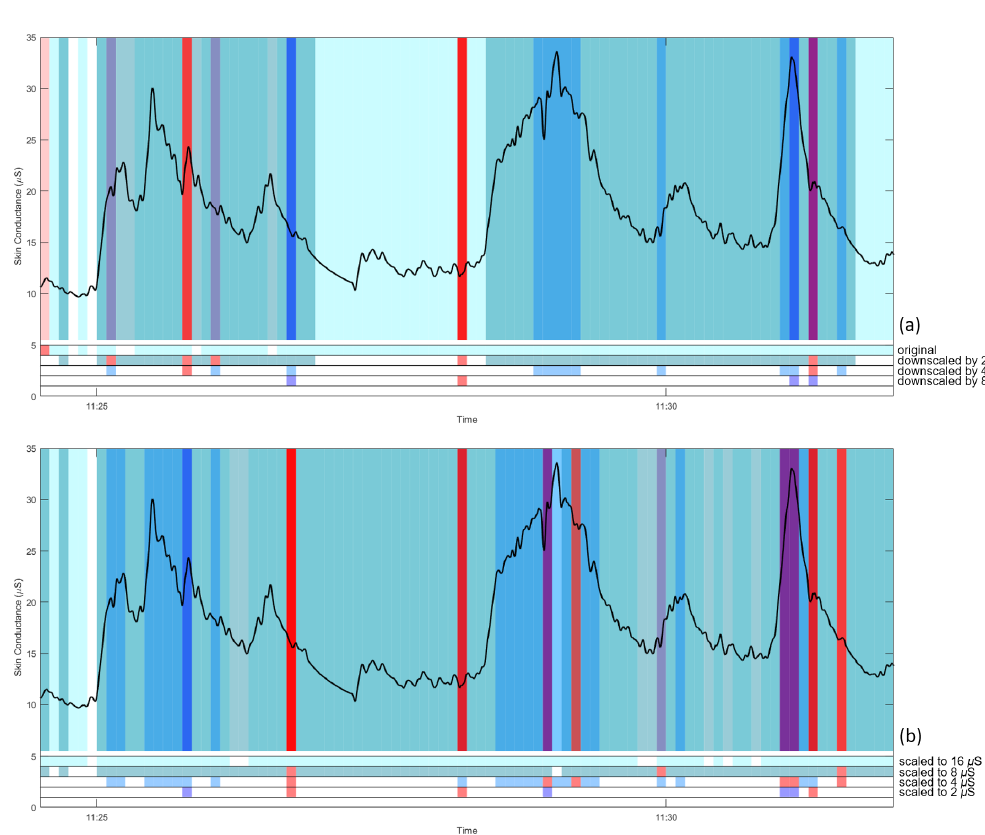
Figure 8. An example of artifactual (red) and questionable (blue-shade) segments as labeled by EDA-Explorer with the variation of the downscaling factors and rescaling to specific levels; ( a ) segments after downscaling (no scaling, 2, 4, 8) and ( b ) segments after rescaling to 16, 8, 4, 2 µ